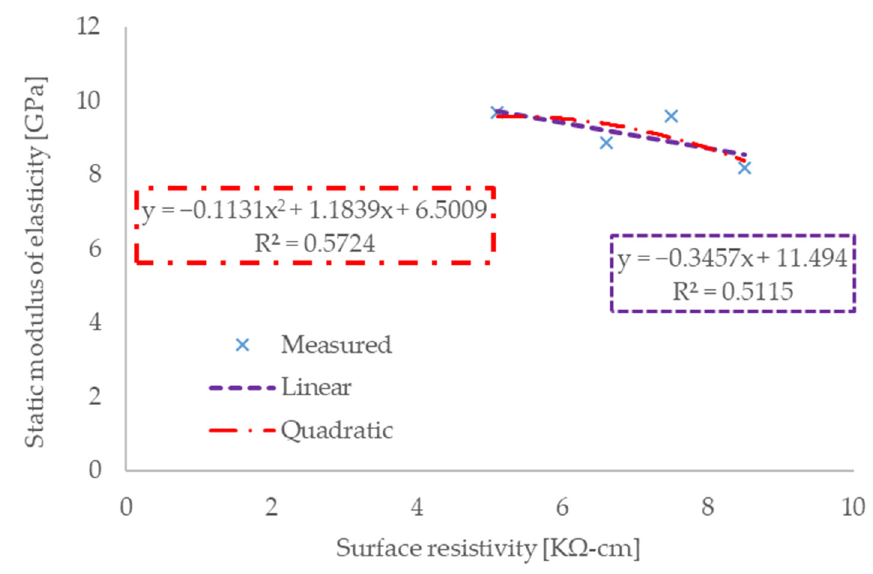
Figure 10. The relationship between surface resistivity and static modulus of elasticity.